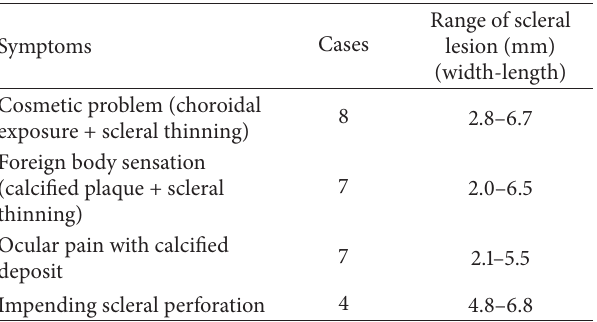
Table 1: The main preoperative symptoms included the size of scleral thinning in 26